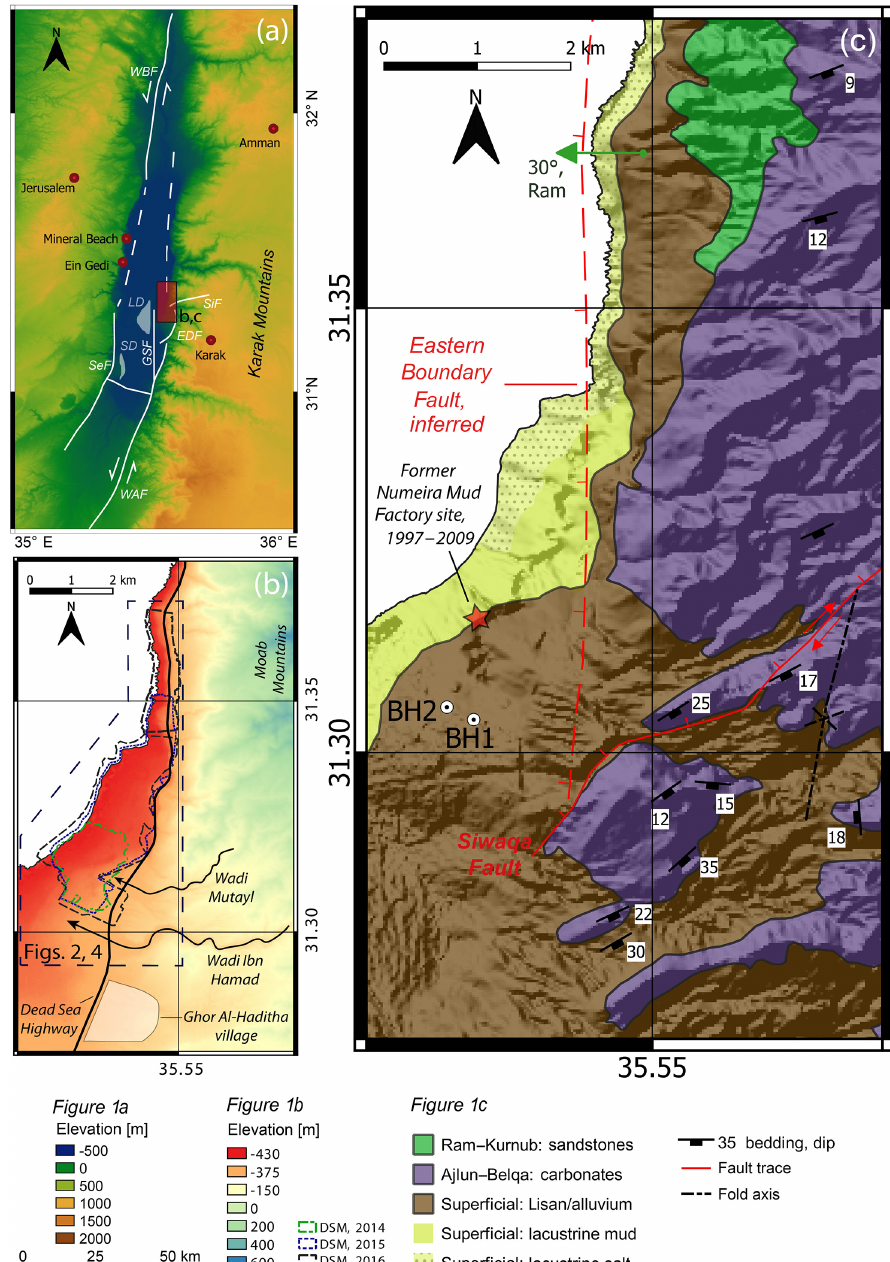
Figure 1. Overview of the Ghor Al-Haditha study area. (a) Advanced Land Observing Satellite (ALOS) 30m digital surface model (DSM) of the Dead Sea study area, showing the regional tectonic regime. WBF: Western Boundary Fault; SiF: Siwaqa Fault; LD: Lisan Diapir; EDF: Ed Dhira Flexure; GSF: Ghor Safi Fault; SD: Sedom Diapir; SeF: Sedom Fault; WAF: Wadi Araba Fault. (b) ALOS 30m DSM showing relief in the study area, as highlighted in red in (a) , along with the footprints of the 2014, 2015 and 2016 drone and field surveys. The flow paths of the Wadi Mutayl and Wadi Ibn Hamad are shown, along with the positions of the regional Dead Sea Highway and the village of Ghor Al-Haditha. (c) Simplified geological map of the study area, partly based on 1 : 50000 scale mapping of Jordanian Ministry of Energy and Mineral Resources (Khalil, 1992) and partly on our own work. The stratigraphy generally dips acutely to the southeast, while striking to the northeast. Also shown is the right-lateral oblique Siwaqa fault, the inferred position of the Eastern Boundary Fault (downthrowing to the east), and the axis of the Haditha syncline. A 30 ◦ bend in the Ram deposits in the north of the study area is also marked on the map; this bend and the 0 ◦ N-trending scarp visible on the map and in (b) are the main features indicating the presence of the Eastern Boundary Fault. The two boreholes of El-Isa et al. (1995) are labelled “BH1” and “BH2”. The red and black star indicates the position of the Numeira Mud Factory, which is now defunct after being destroyed by sinkhole formation at the